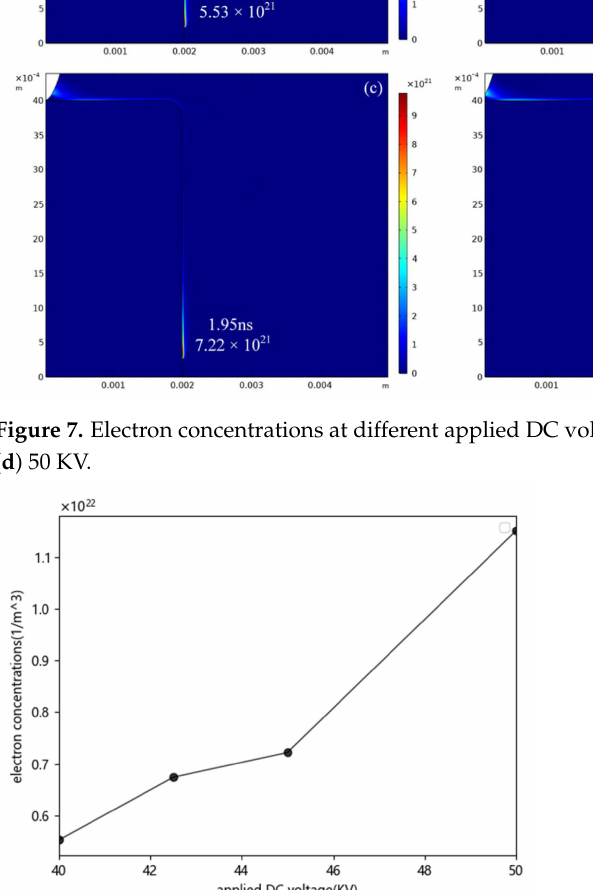
Figure 8. Variation of electron concentrations with applied DC voltage.